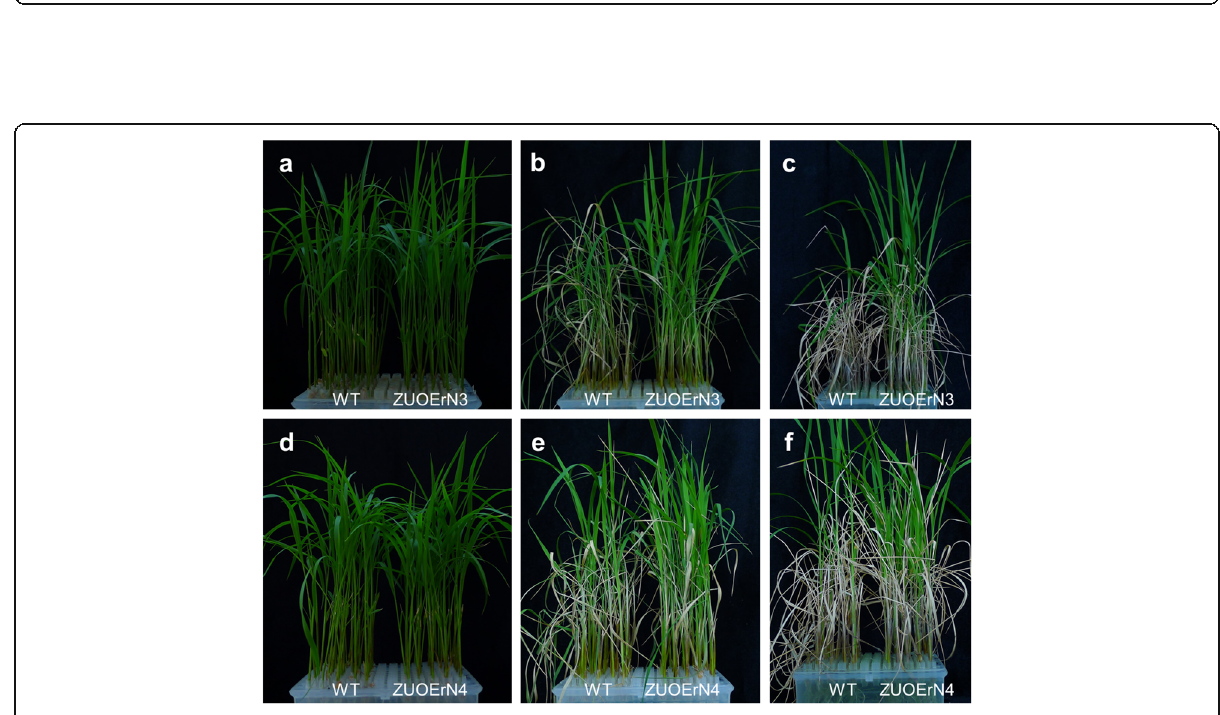
Fig. 4 Salt tolerance of WT and OsNAC2 overexpression plants. Seeds were germinated in water and transferred to Kimura B nutrient solution. Two-week-old seedlings were treated in Kimura B nutrient solution with 50 mM sodium chloride. WT and OsNA C2 overexpression plants (ZUONrE3 and ZUOErN4) before treatment ( a , d ), 50 mM sodium chloride treated for 8 d ( b, e ), and then recovery for 8 d ( c, f ) are